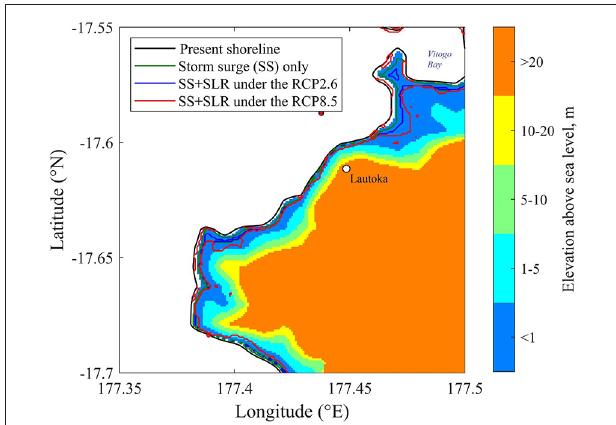
FIGURE 9 | Inundated area due to the compound effects in location #2, Lautoka area, (see Figure 3B ). The black line corresponds to the coastline under present climate condition, the green line corresponds to storm surge inundation only, the blue and red lines correspond to the maximum inundation edge due to storm surge with SLR under the RCP2.6 and RCP8.5 scenarios,